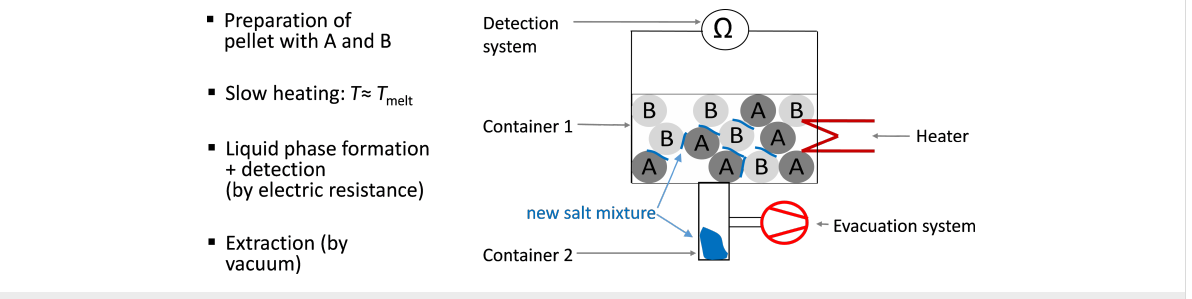
Figure 9: Schematic of the novel experimental method and apparatus to synthesize new salt mixtures.